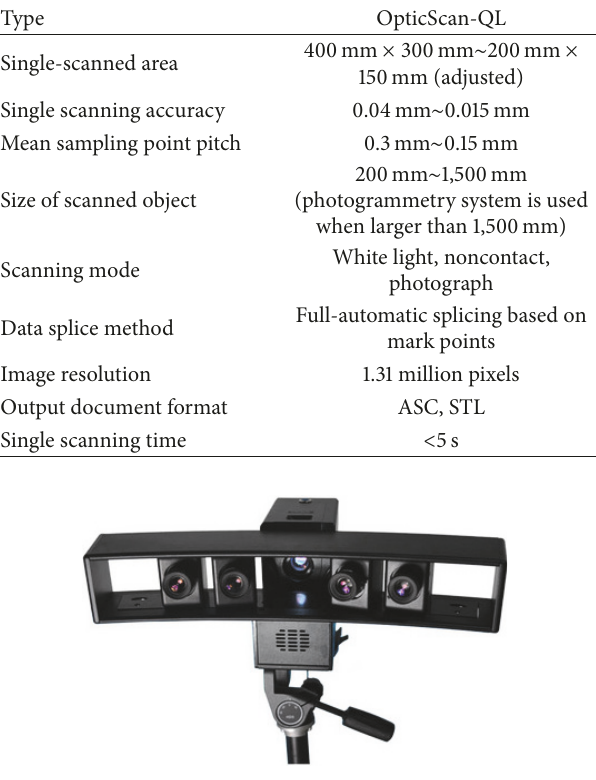
Figure 3: OpticScan-QL 3D scanning system.